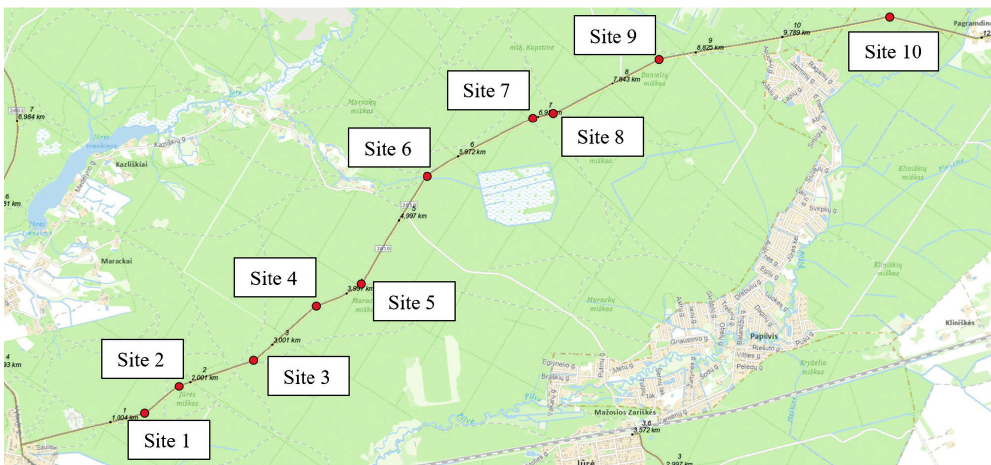
Figure 2. Speed measurements sites along the road No.